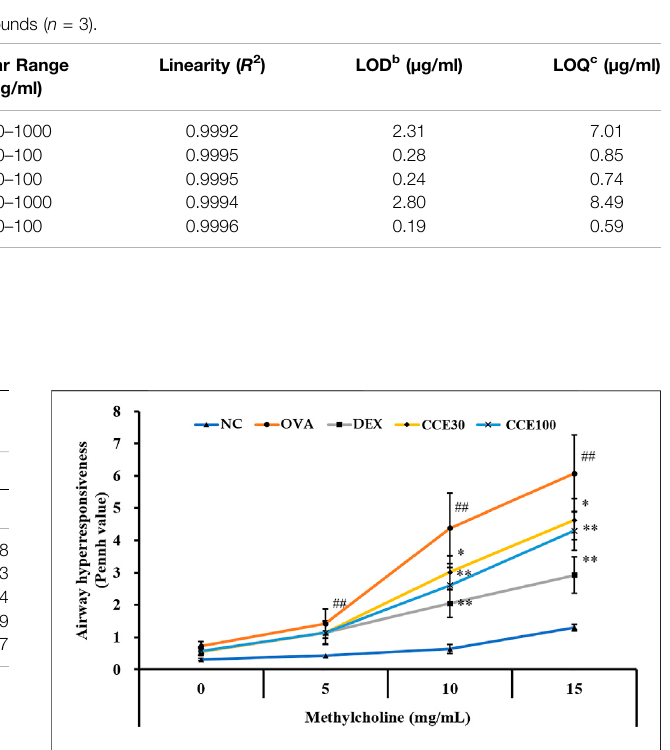
FIGURE2| CCEreducedtheelevatedAHRinOVA-exposedmice.AHR was measured by whole-body plethysmograph. NC, nonasthma and PBS treatment; OVA, asthma and PBS treatment; DEX, asthma and dexamethasone treatment; CCE 30 and CCE 100, asthma and